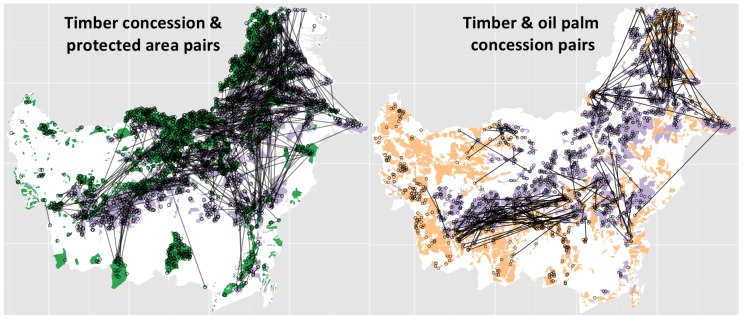
The spatial distribution of the 575 pairs for the natural forest timber concession (purple) versus protected area (green) analysis (left panel).The spatial distribution of the 194 pairs for the natural forest timber concession (grey) versus oil palm concessions (orange) analysis (right panel).